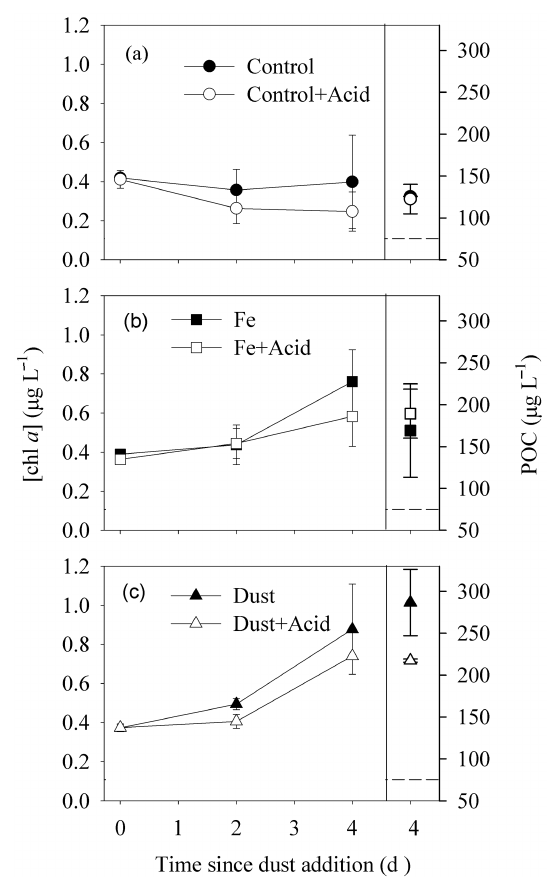
Figure 2. Average concentration of chl a (left axis) during the incu- bations and POC at T4 (right axis) in each treatment. Panel (a) : Control and Control + Acid. Panel (b) : Fe and Fe + Acid. Panel (c) : Dust and Dust + Acid. Error bars indicate standard deviations. Dashed line indicates POC concentration at T0. Chl a : n = 3 ex- cept for Acid, T0, Dust + Acid, T4, Fe + Acid, T0, and Control (all times), where n = 2 because of missing or unreliable data or con- tamination (Control 1). POC: n = 3 except Control, where n =